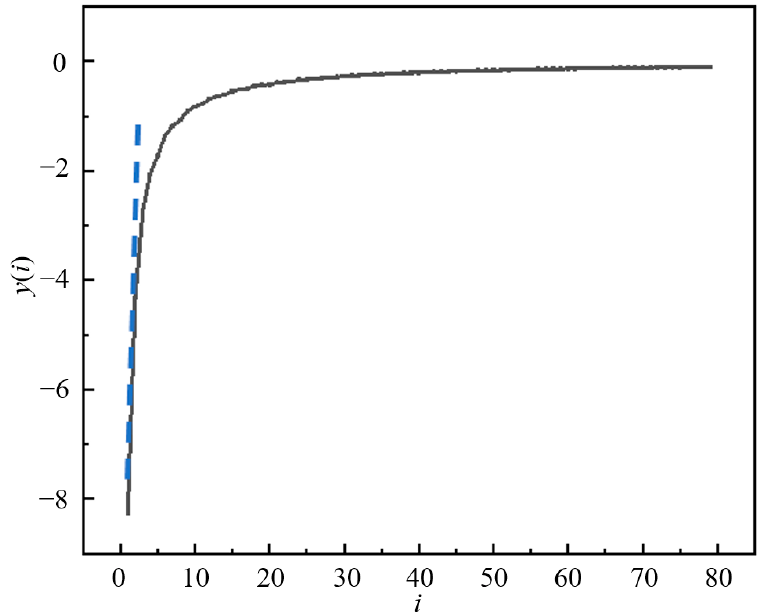
Figure 19. Maximum Lyapunov exponent.